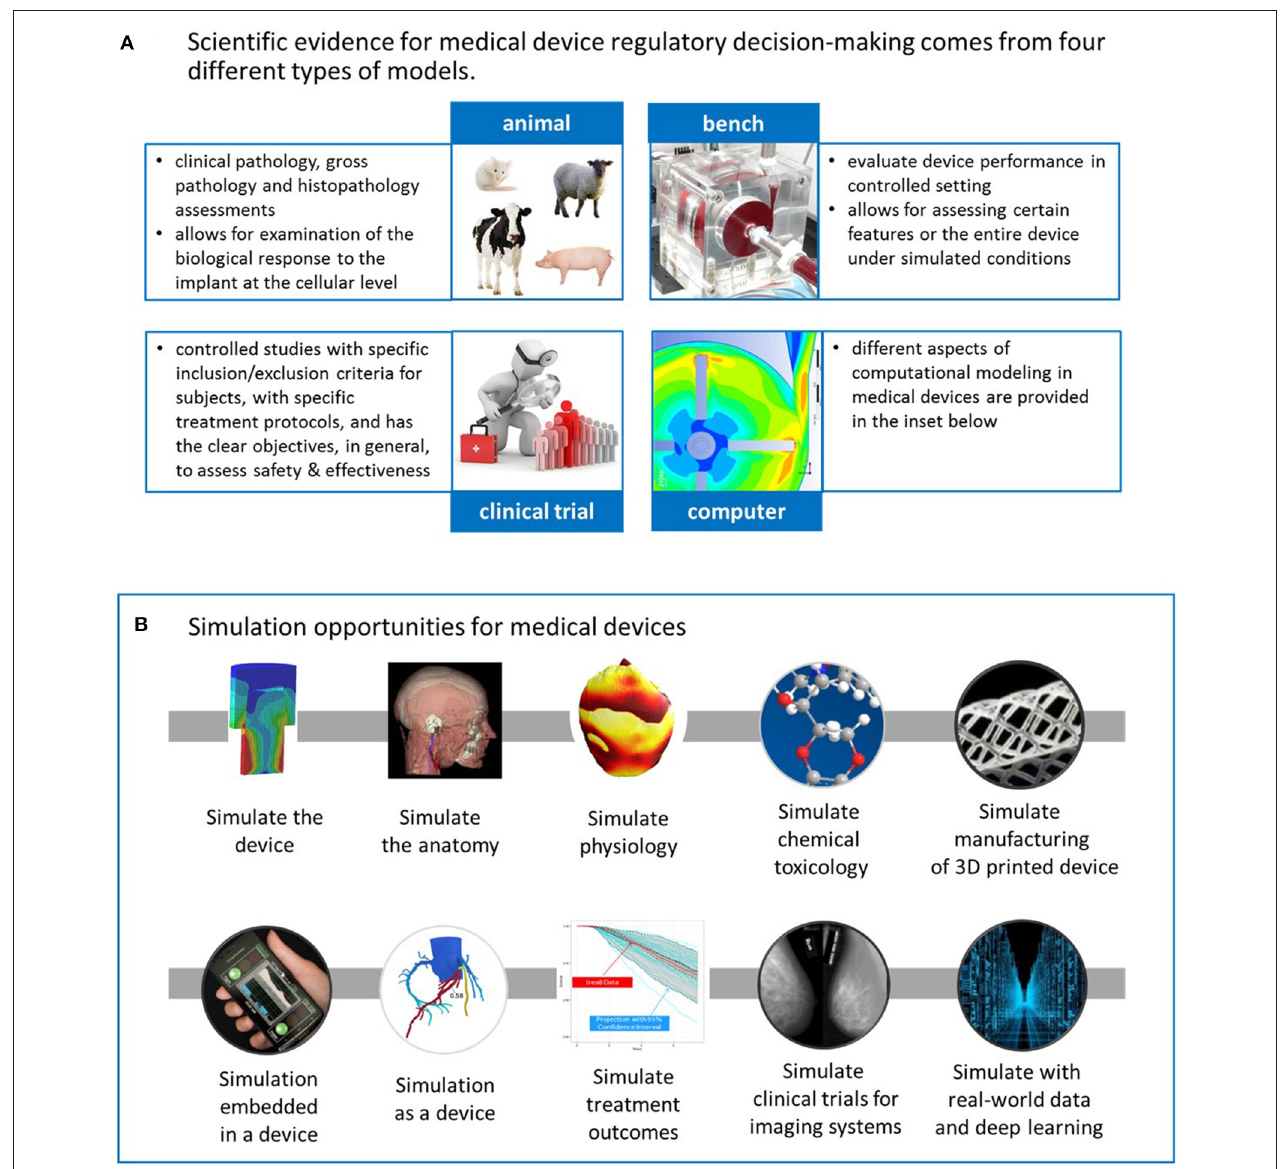
FIGURE 1 | (A) CDRH’s science-based regulatory decisions about medical devices are made with evidence collected from four different models: animal, bench, computational, and human (i.e., clinical trials). (B) Computational modeling has the potential to transform medical device design and evaluation in several ways. The upper row consists of applications that typically support the design or evaluation of the physical device. The lower row represents other applications, such as those embedded in a device or simulation as a medical device. Moreover, computational modeling can also simulate treatment outcomes or simulate the clinical trial for imaging systems. Lastly, it can play a critical role in the development of data-driven models from real-world data. See the text for more details.